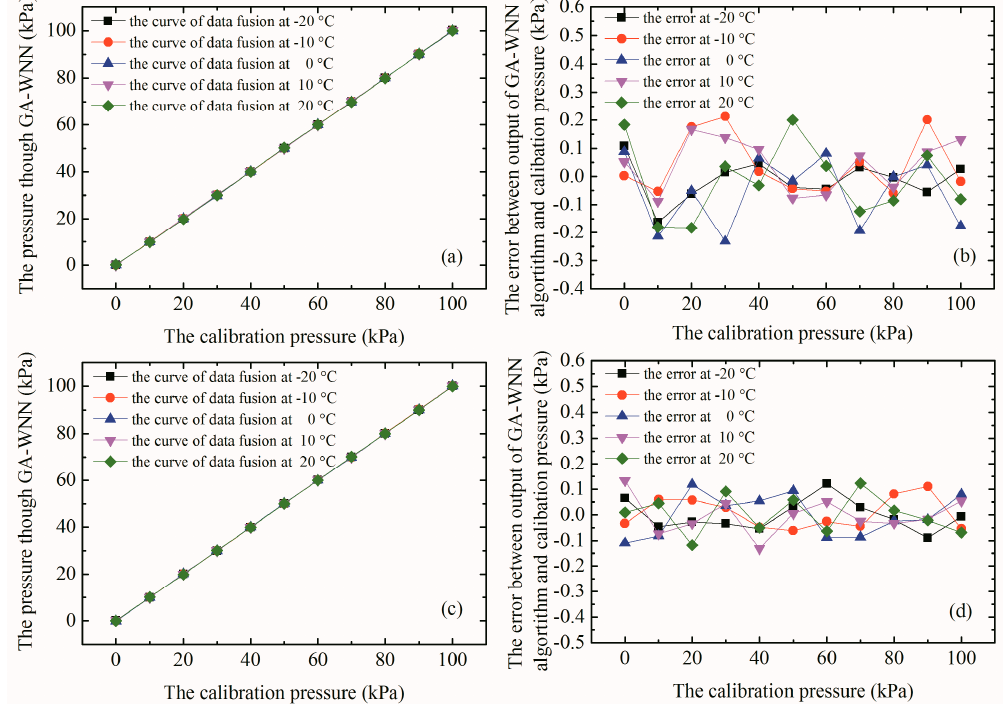
Figure 17. ( a ) The relationship curves between the corrected pressures of PS1/PS2 sensor and the calibration pressures with pressure from 0–100 kPa; ( b ) the absolute error between the corrected pressures of PS1/PS2 sensor and the calibration pressures at different temperature; ( c ) the relationship curves between the corrected pressures of PS3/PS4 sensor and the calibration pressures with pressure from 0–100 kPa; and ( d ) the absolute error between the corrected pressures of PS3/PS4 sensor and the calibration pressures at different temperature.